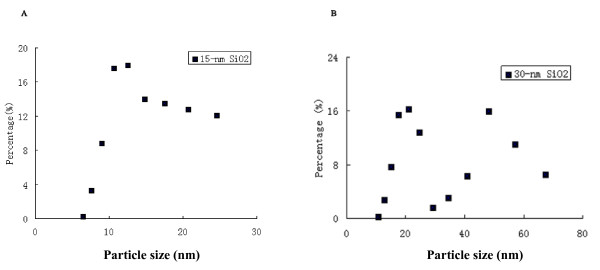
The distribution of the three types of SiO2 particles. The particle size distribution of 15-nm and 30-nm SiO2 was shown in A and B, respectively.